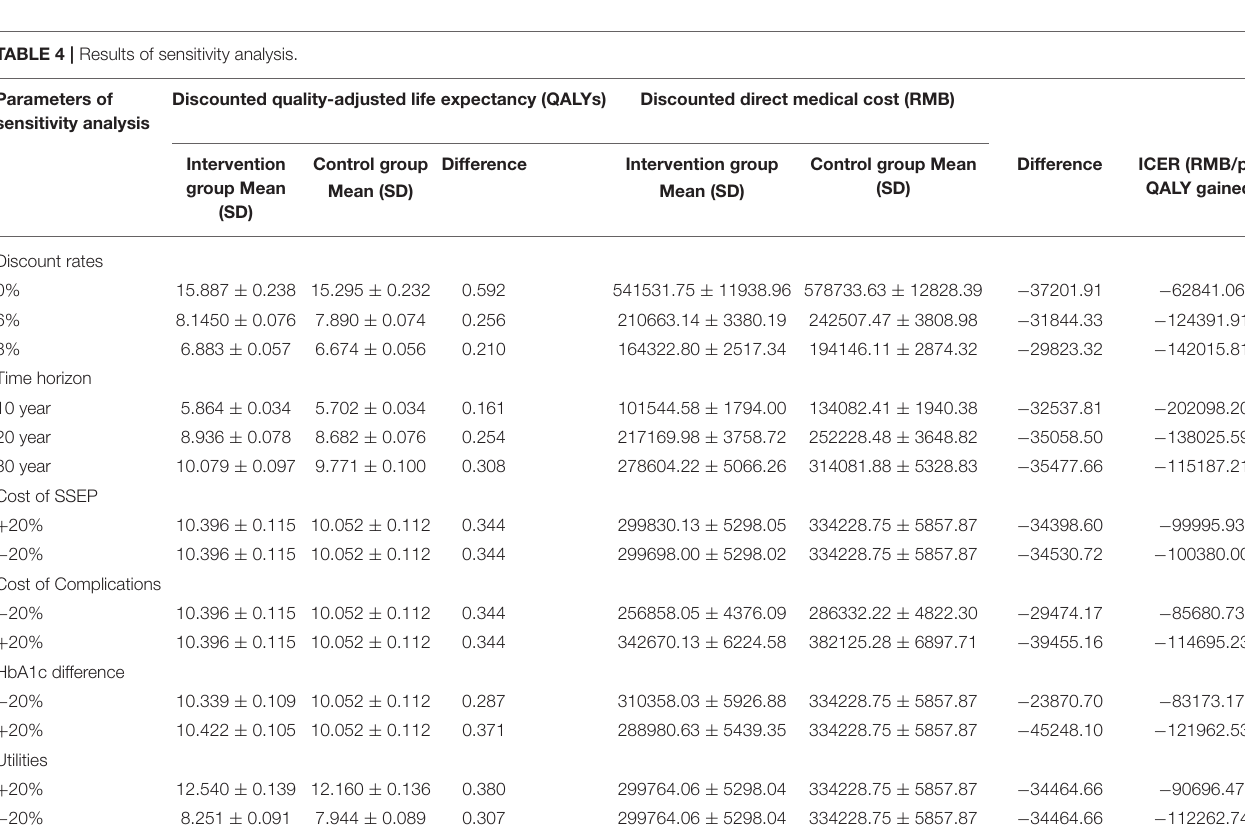
TABLE 4 | Results of sensitivity